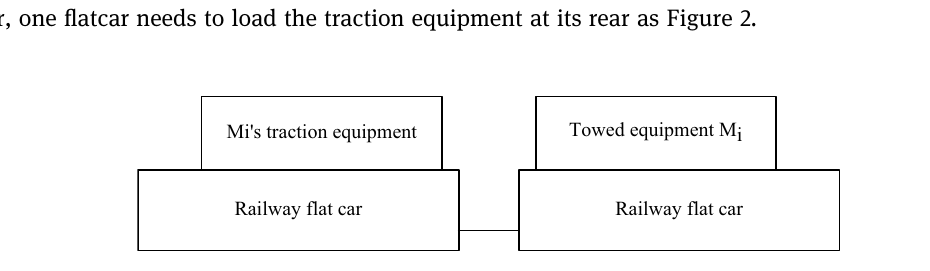
Figure 2: Optimization of loading scheme for traction equipment.